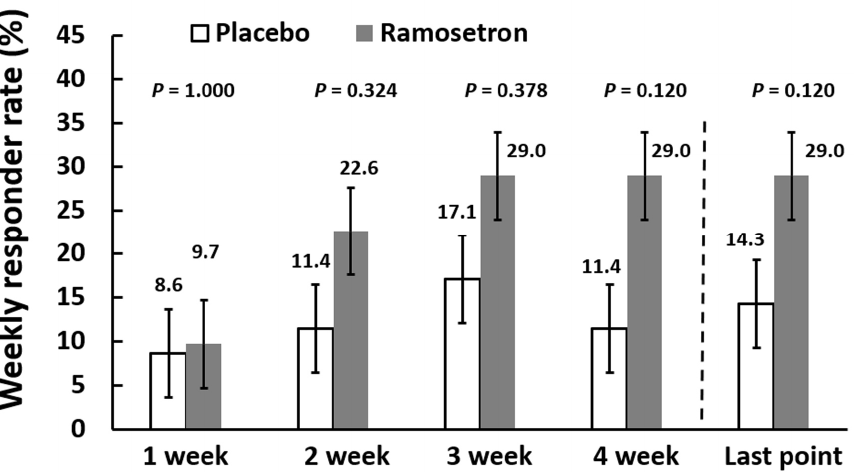
Figure 4. Weekly responder rates for relief of abdominal discomfort/pain. Results are expressed as mean ± SD.